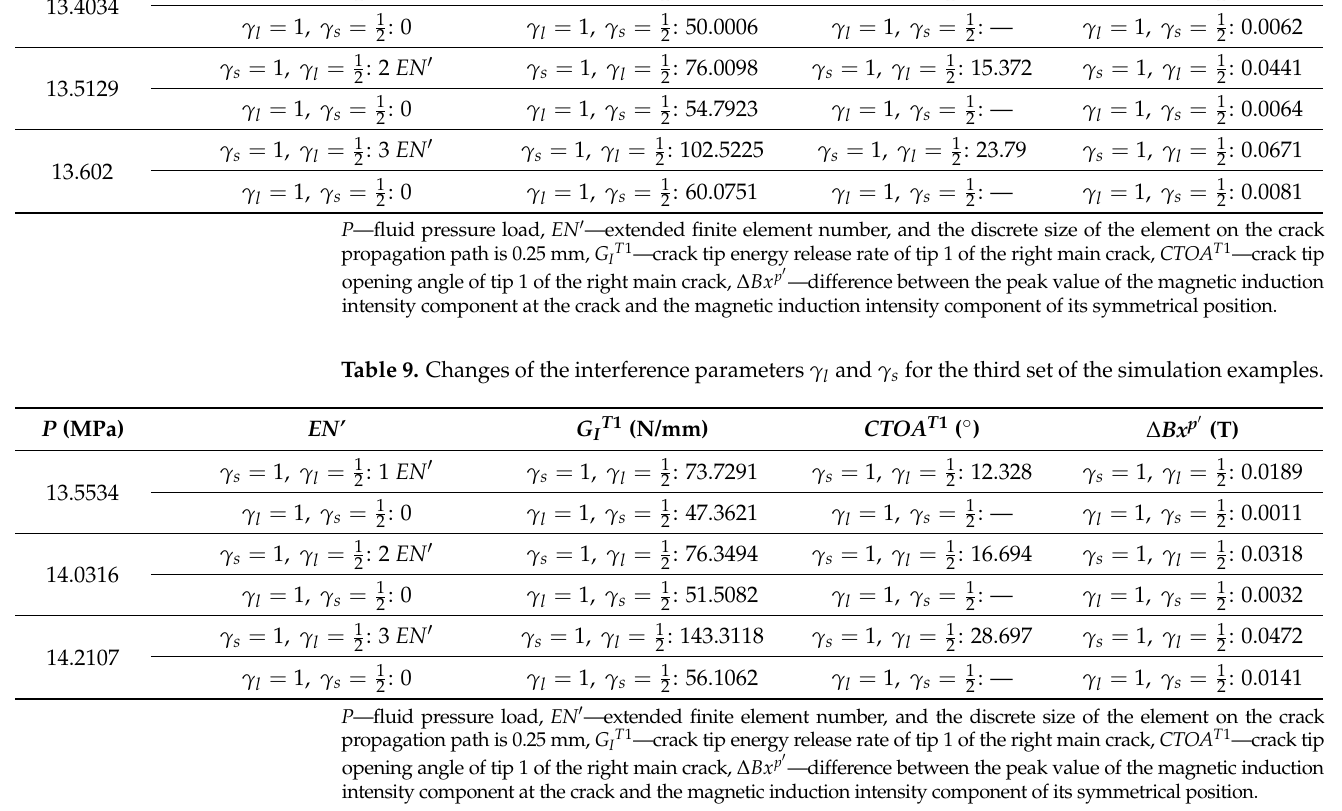
and 𝛾 for the third set of the simulation (cid:3039) (cid:3046)